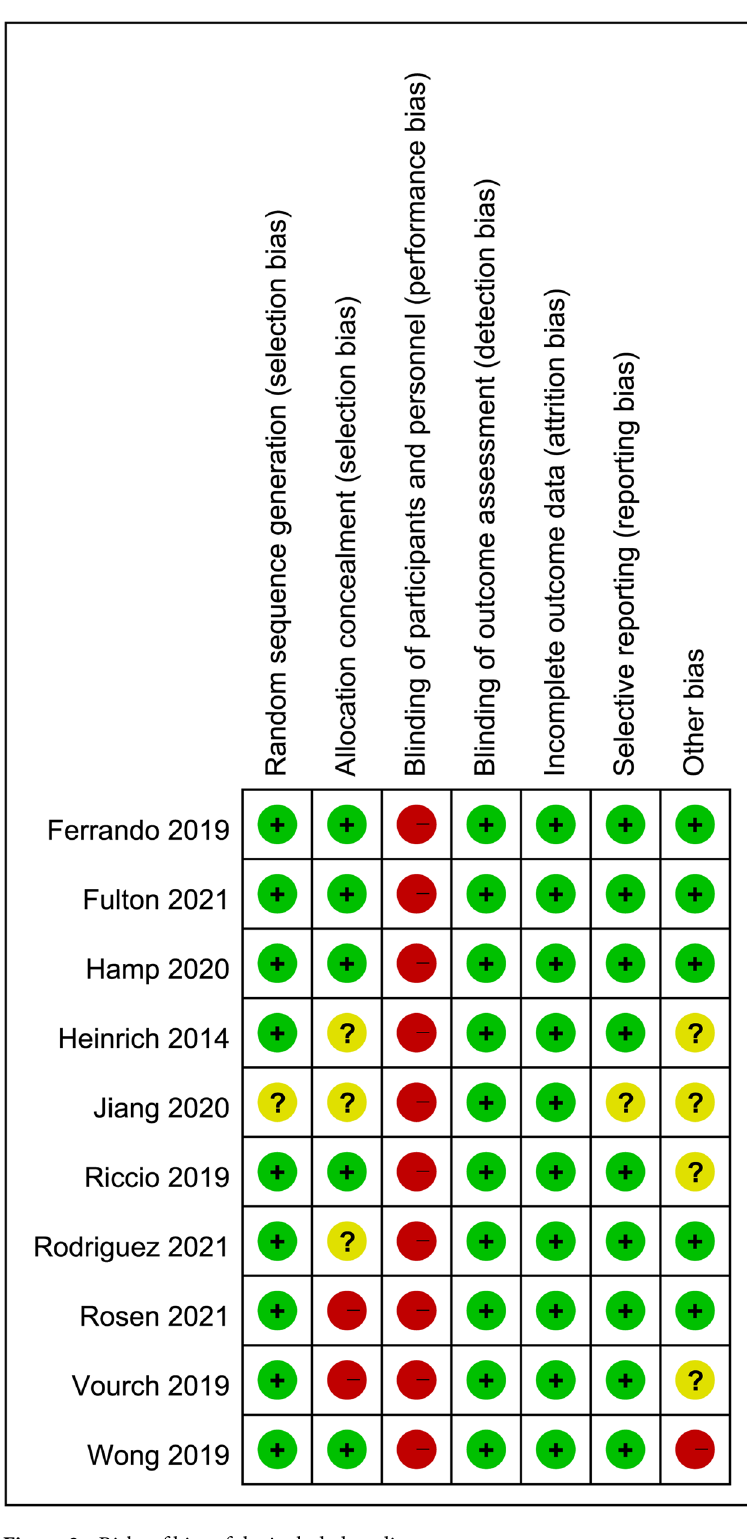
Figure 2. Risks of bias of the included